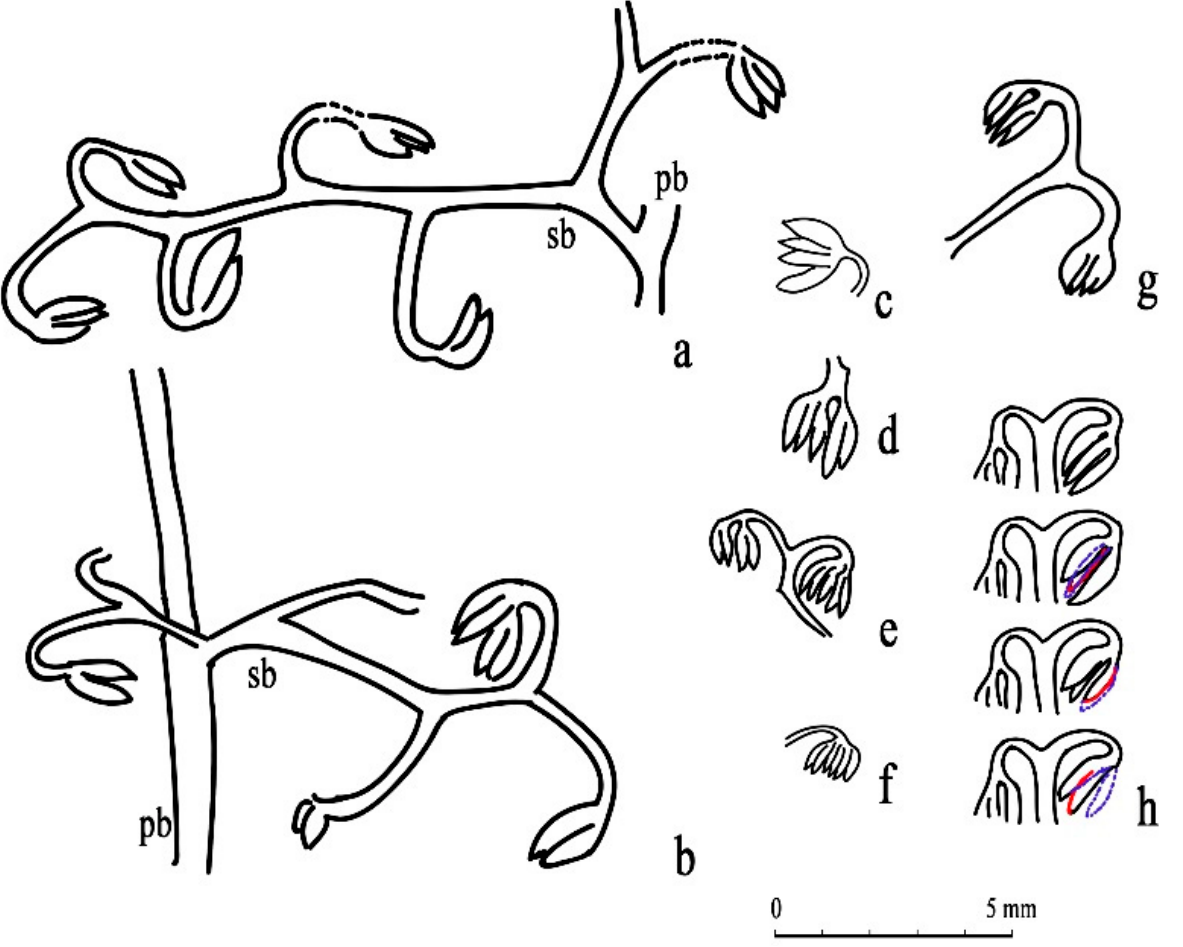
Figure 6. Morphology of Xinhangia spina gen. et sp. nov. from Guangde City, Anhui Province, China. ( a – h ) Line drawing of part of fertile branches and fertile organs in Figure 5 showing terminal sporangial pairs. ( a – g ) correspond to Figure 5D,G,A,C,I,K, respectively, and ( h ) corresponds to the serial d é gagement of Figure 5T–W, where blue dotted lines and red lines indicate removed and newly exposed parts, respectively. pb, primary branch; sb, secondary